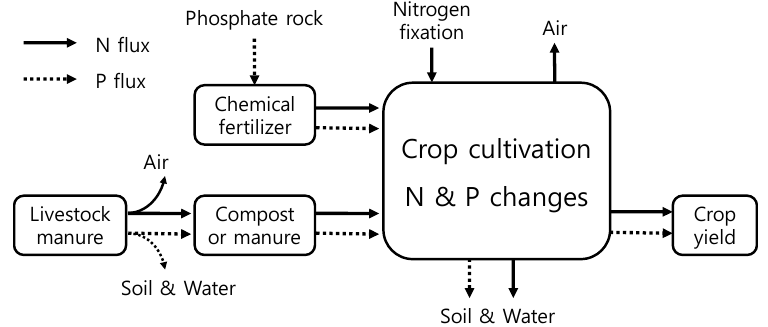
Figure 1. Nutrient (N and P) flux in agricultural sector. N, nitrogen; P, phosphorus.